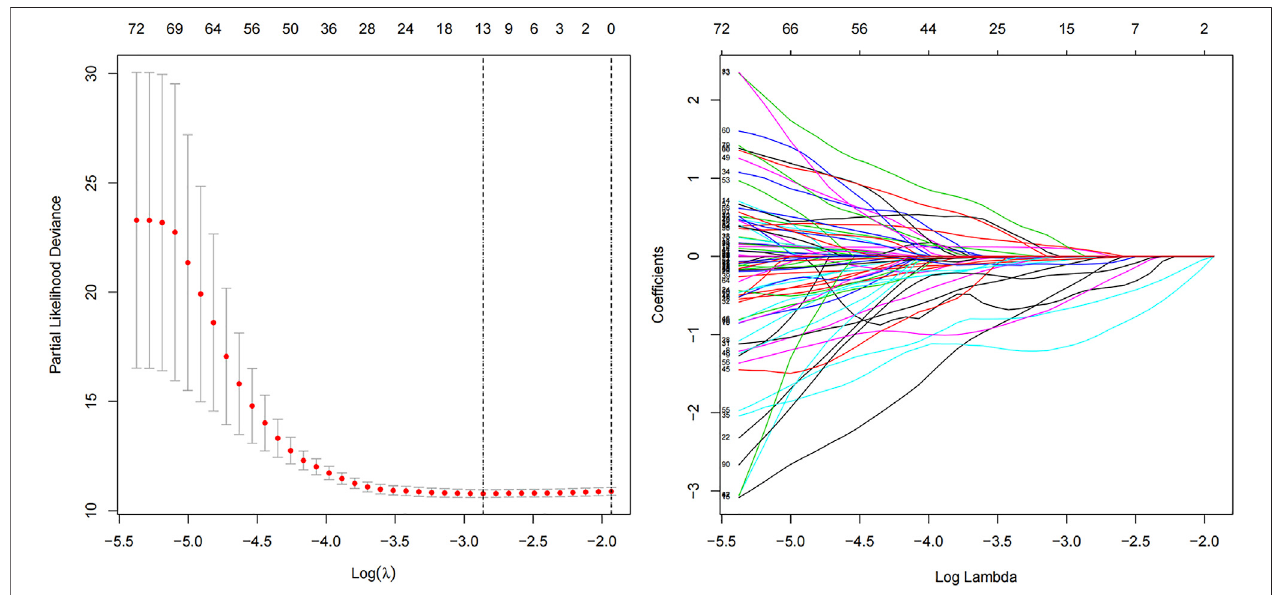
FIGURE 5 | LASSO Cox regression analysis of prognostic m6A-related lncRNAs.